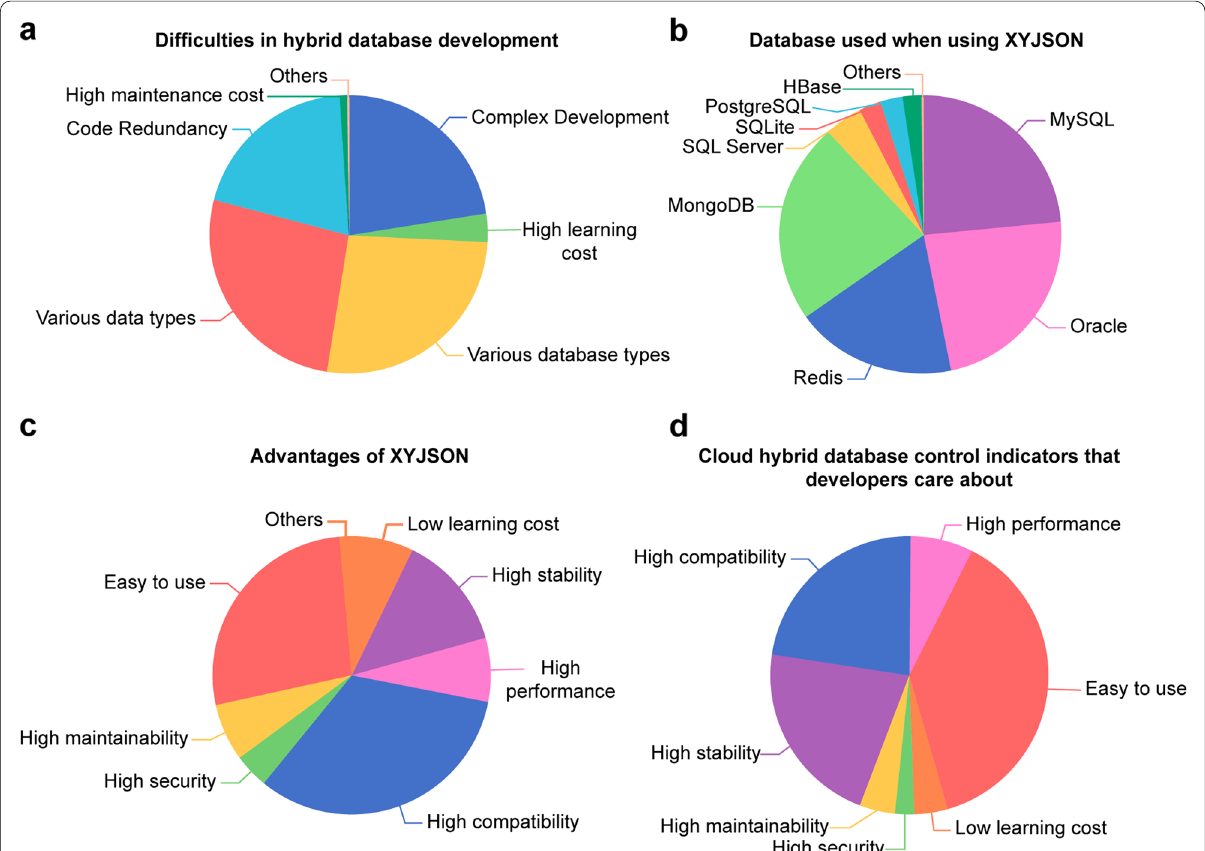
Fig. 9 Developer survey statistics ( a ) Difficulties in hybrid database development ( b ) Database used with XYJSON ( c ) Advantages of XYJSON ( d ) Cloud hybrid database control indicators considered by